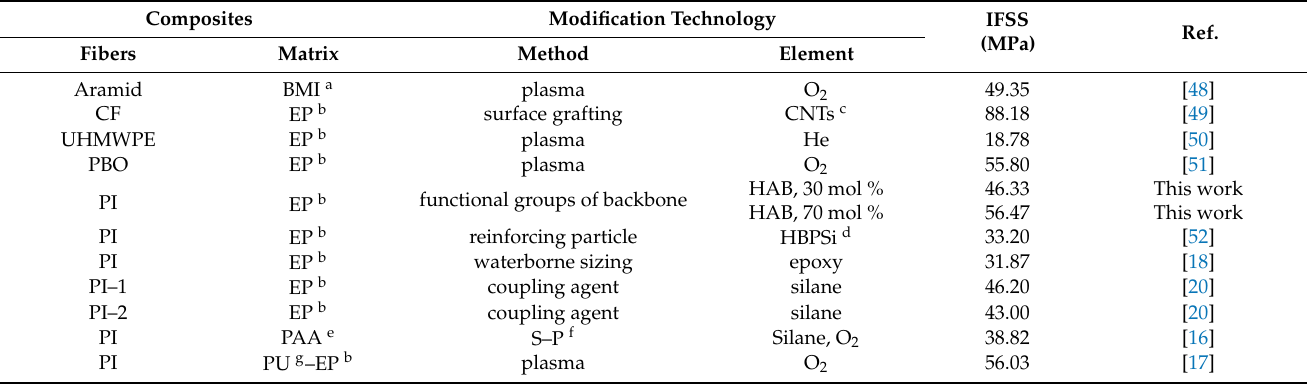
Table 4. IFSS values of the different modification methods for